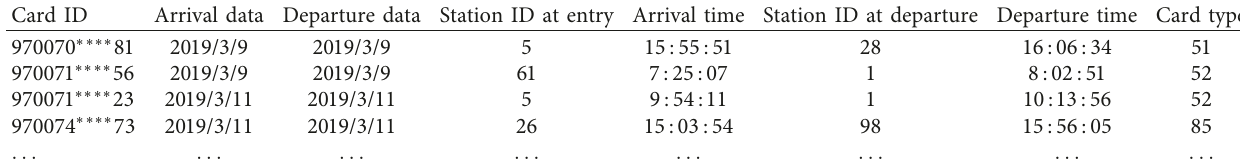
Table 1: Metro smart card data samples on March